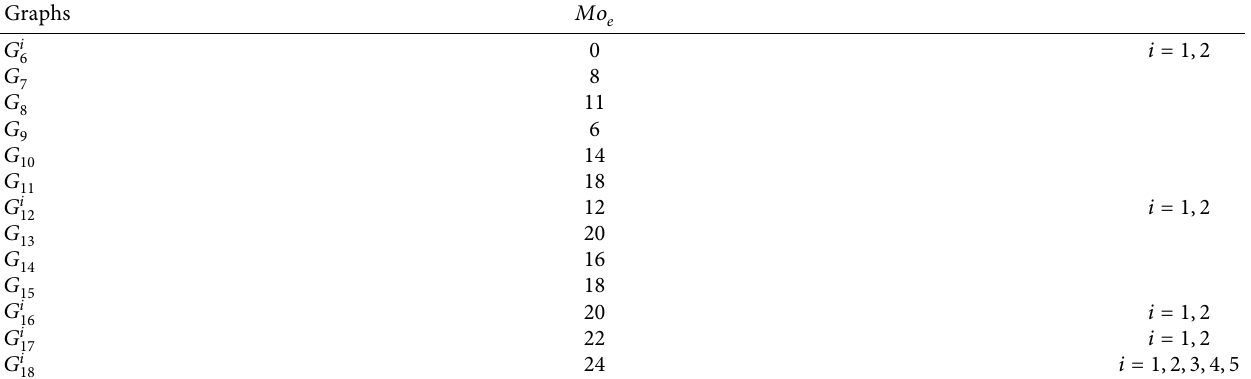
Table 3: The edge Mostar index of graphs in Figure 12.